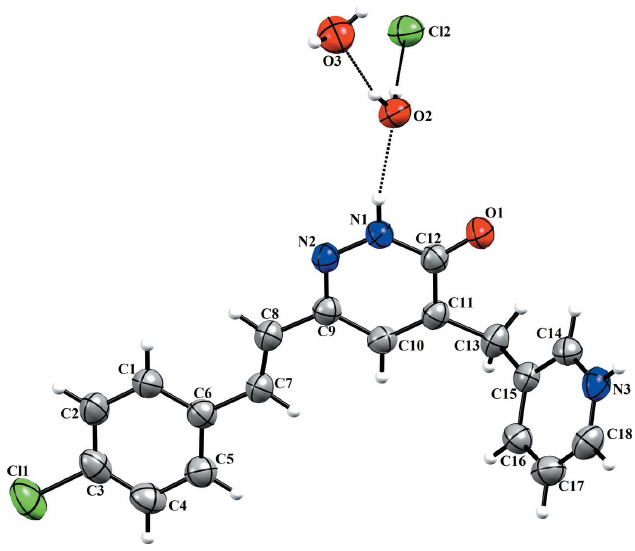
Figure 1 Perspective view and atom labelling of the molecule. Displacement ellipsoids are drawn at the 50% probability